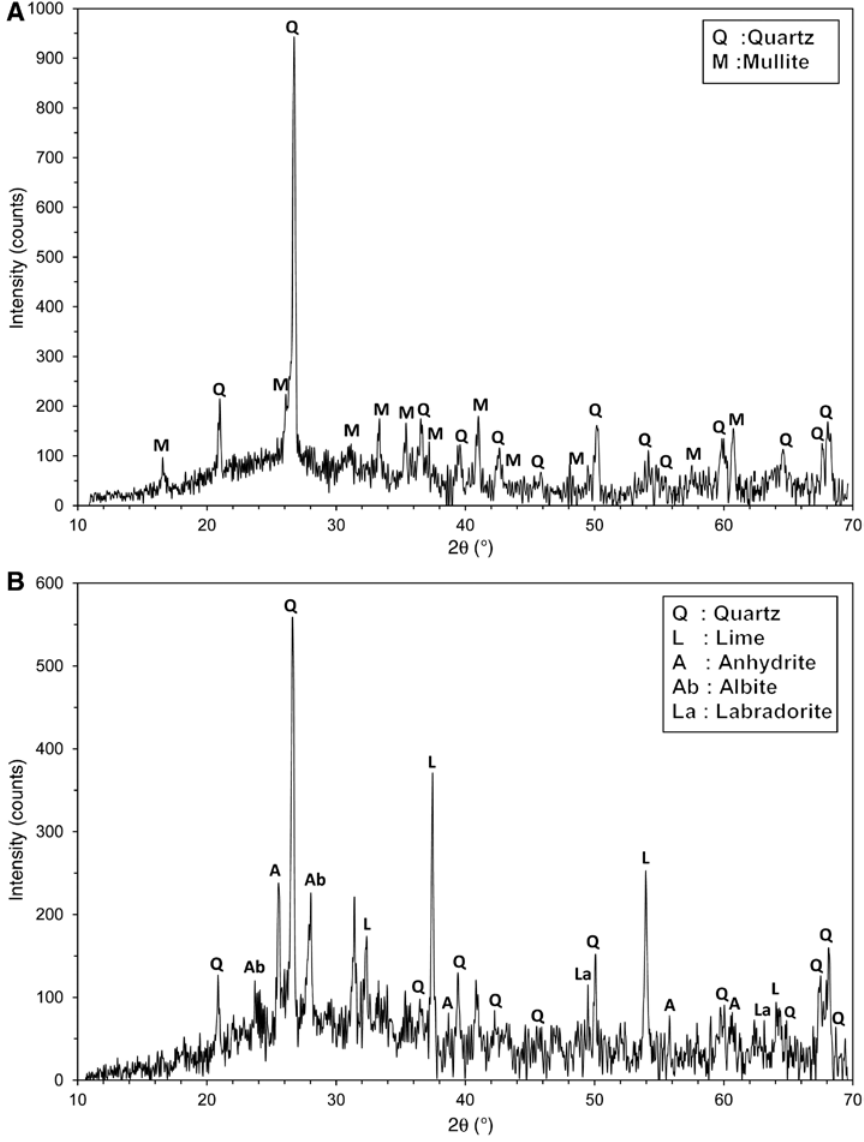
Figure 2: X-ray diffraction (XRD) pattern of fly ashes (A) Catalagzi fly ash and (B) Soma fly